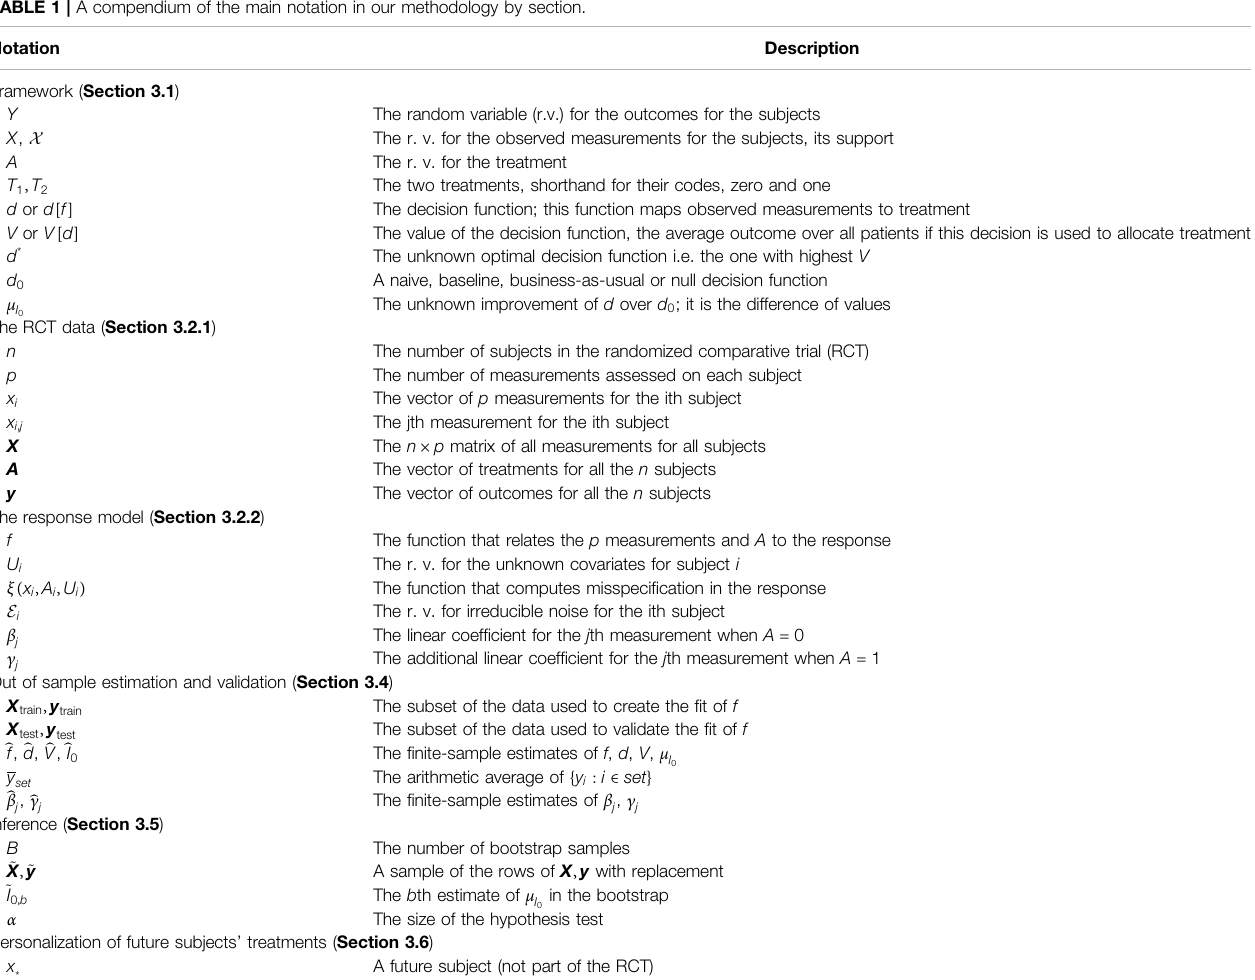
TABLE 1 | A compendium of the main notation in our methodology by